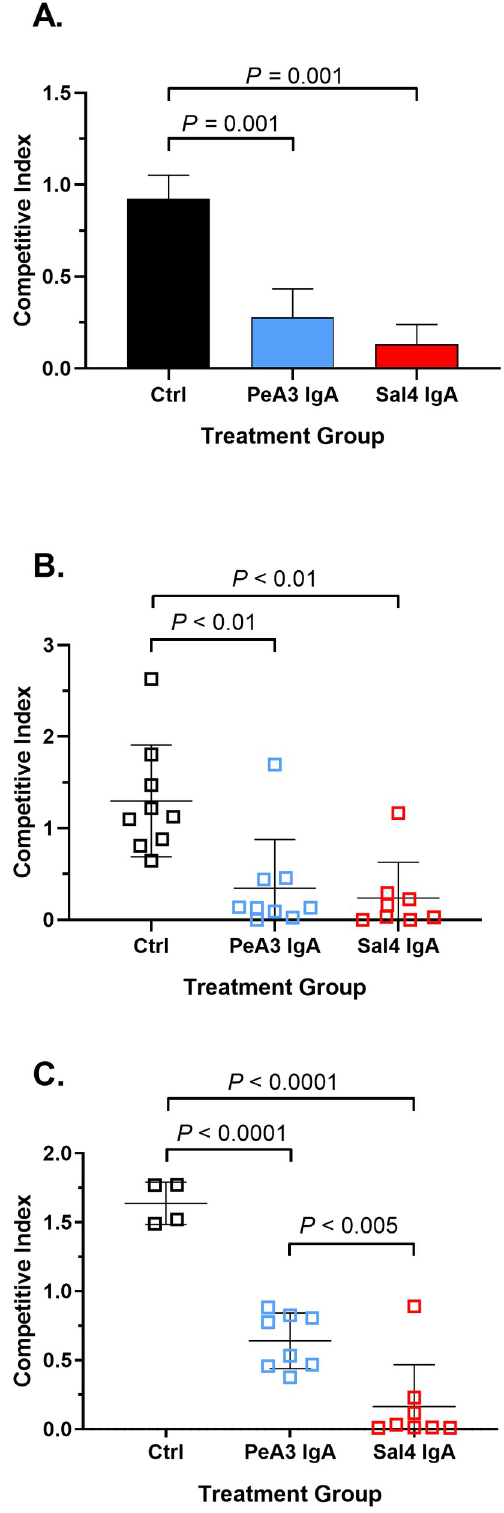
Fig 2. PeA3 IgA blocks wildtype STm invasion in vitro and in vivo . (A) A 1:1 mixture of AR04 and AR05 STm strains was treated with Sal4 IgA, PeA3 IgA, or isotype control antibody and applied to HeLa cells. Monolayers